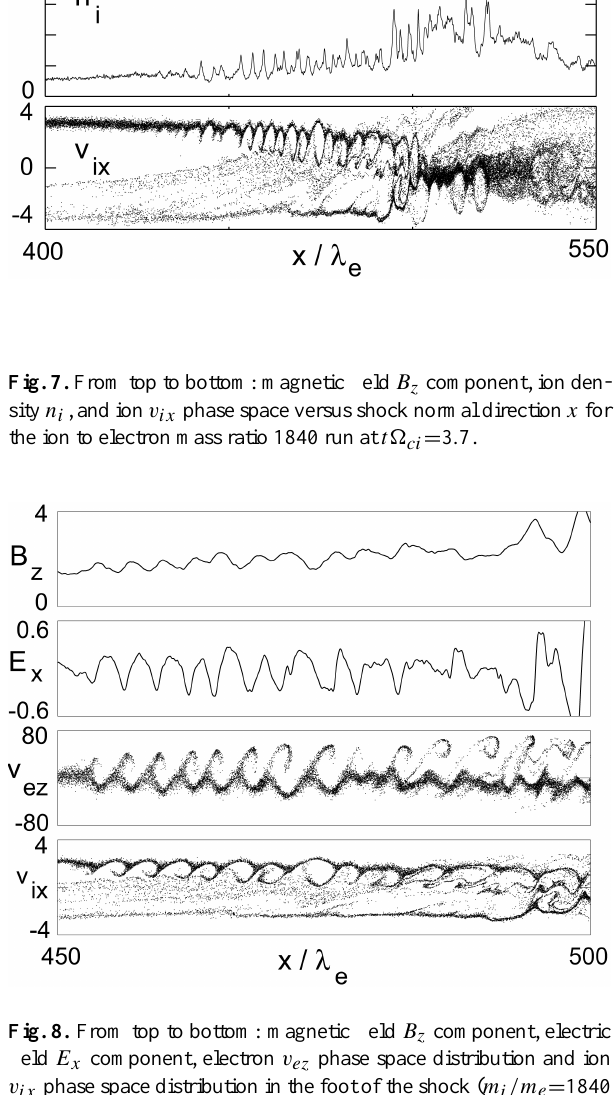
Fig. 8. From top to bottom: magnetic field B z component, electric field E x component, electron v ez phase space distribution and ion v ix phase space distribution in the foot of the shock ( m i /m e = 1840 run) at t(cid:127) ci = 3 .